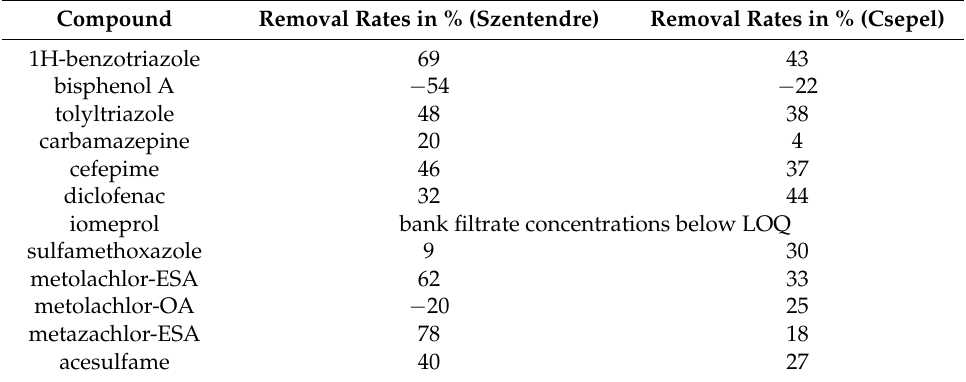
Table 4. Median removal rates of the most prominent compounds in the River Danube water and bank filtrate at sampling points on Szentendre Island and Csepel